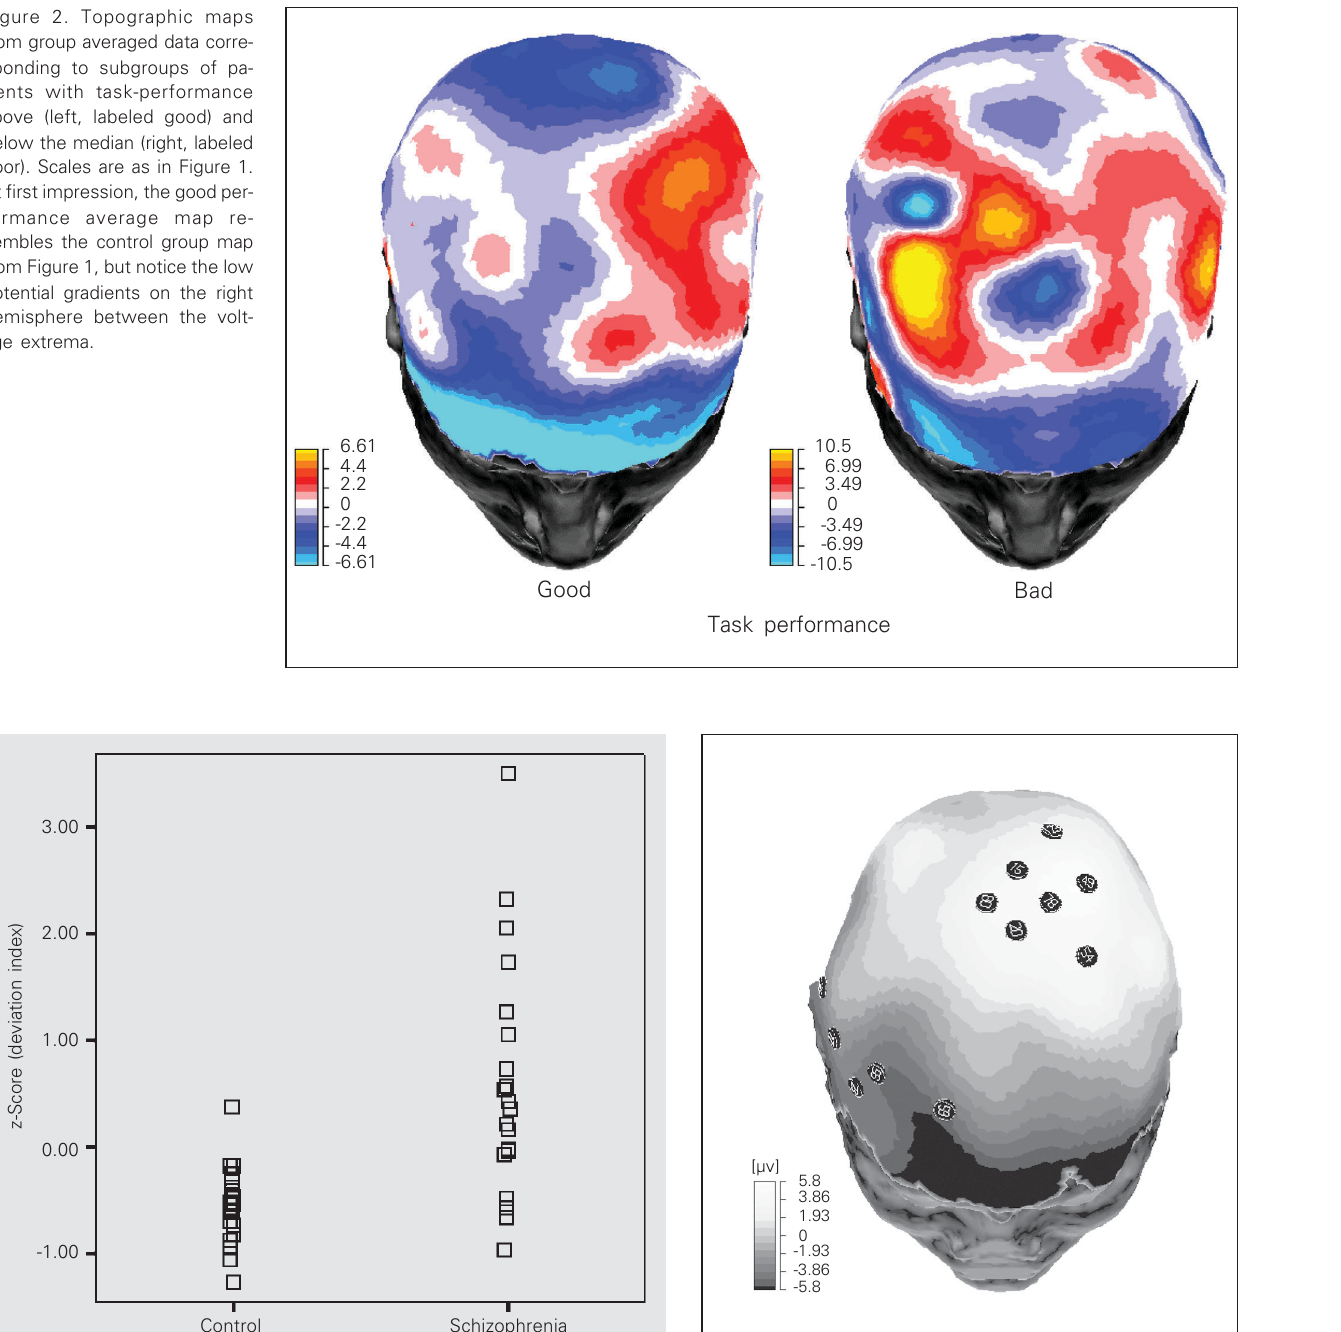
Figure 3. Topographic deviation scatterplot, with electrical power (originally in µV) transformed into z-scores. Each score was obtained from the root mean square of the channel-by-channel differences between individual slow potential amplitude and the group averaged potentials (controls plus patients). The control group consisted of 22 subjects and the schizophrenic group of 20 patients.